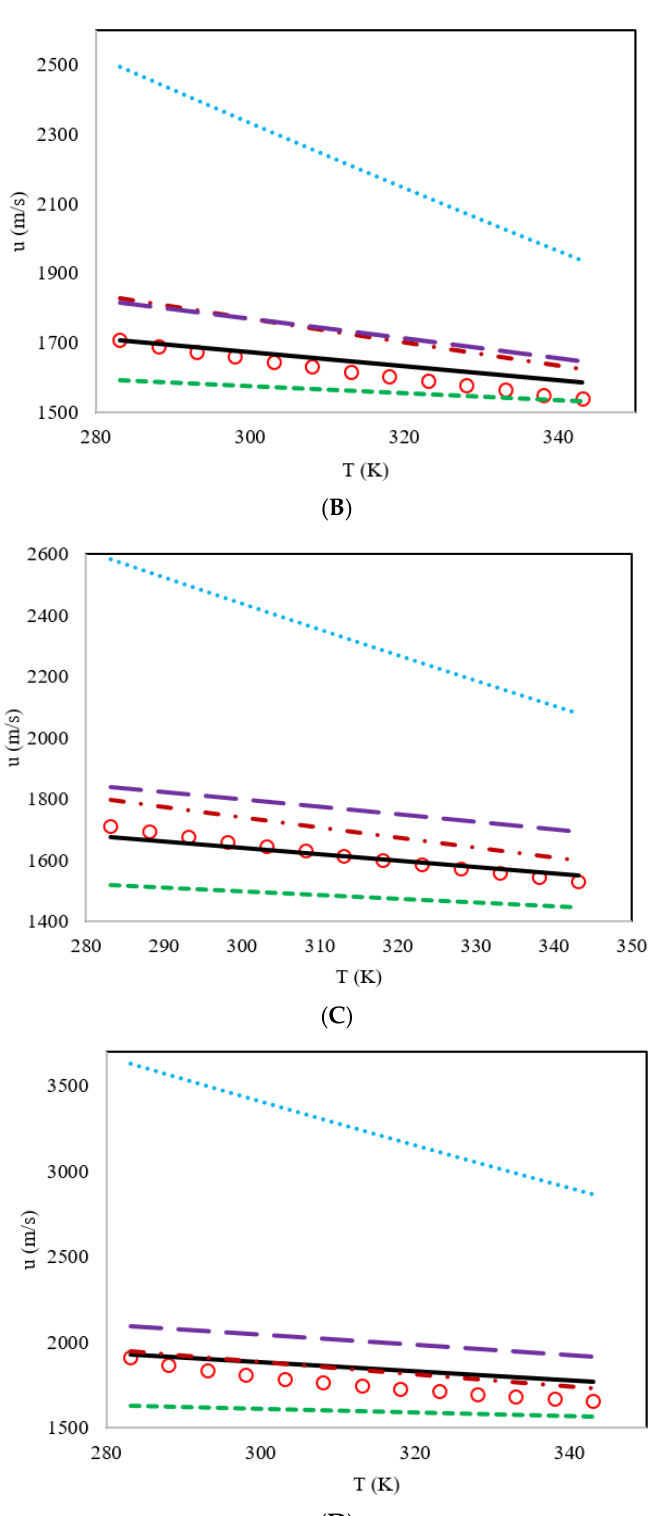
Figure 4. Comparison of the behavior of the speed of sound versus the temperature for the proposed model and literature models for four members of the DES family having benzyl tributyl ammonium chloride as the HBA and the different HBDs of ethylene glycol (DES4) ( A ), diethylene glycol (DES5) ( B ), triethylene glycol (DES6) ( C ) and glycerol (DES7) ( D ). Experimental data o , proposed model ― , Haghbakhsh et al.’s model [24] — , Gardas and Coutinho’s model [27] — —, Hekayati and Esmaeilzadeh’s model [28] · – · – and Singh and Singh’s model [29] ···